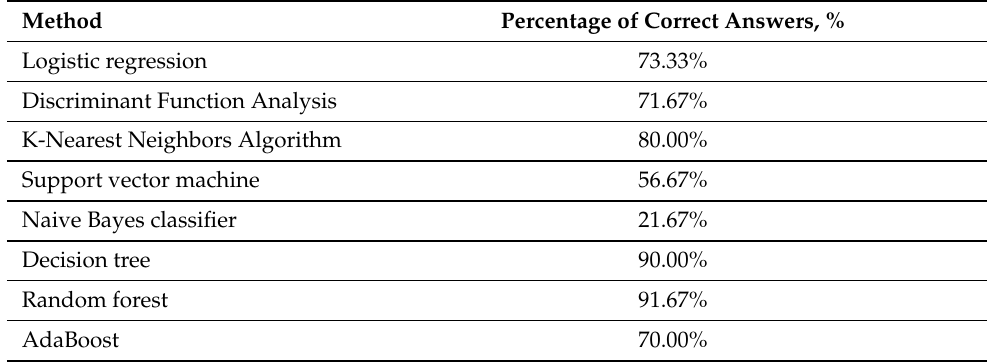
Table 2. Percentage of correct answers on the test set for various basic machine learning methods.